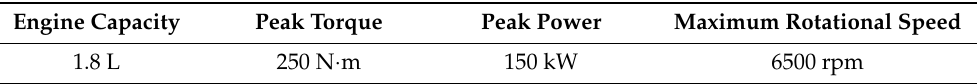
Table 3. Engine parameters of four-wheel drive